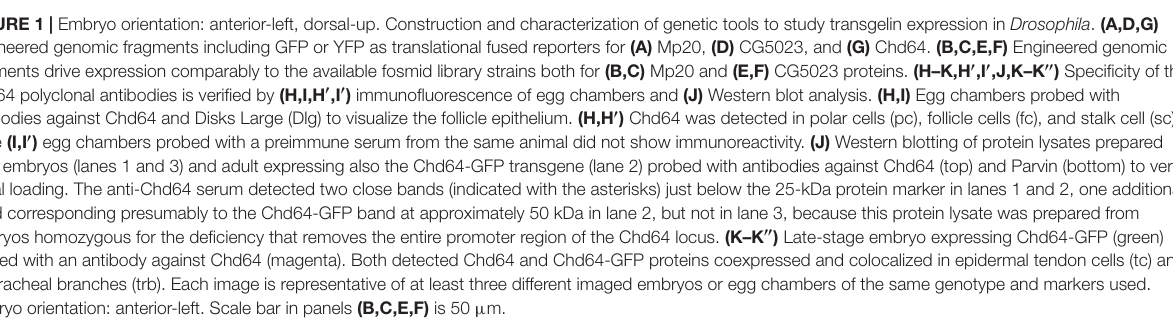
FIGURE 1 | Embryo orientation: anterior-left, dorsal-up. Construction and characterization of genetic tools to study transgelin expression in Drosophila . (A,D,G) Engineered genomic fragments including GFP or YFP as translational fused reporters for (A) Mp20, (D) CG5023, and (G) Chd64. (B,C,E,F) Engineered genomic fragments drive expression comparably to the available fosmid library strains both for (B,C) Mp20 and (E,F) CG5023 proteins. (H–K,H (cid:48) ,I (cid:48) ,J,K–K (cid:48)(cid:48) ) Specificity of the Chd64 polyclonal antibodies is verified by (H,I,H (cid:48) ,I (cid:48) ) immunofluorescence of egg chambers and (J) Western blot analysis. (H,I) Egg chambers probed with antibodies against Chd64 and Disks Large (Dlg) to visualize the follicle epithelium. (H,H (cid:48) ) Chd64 was detected in polar cells (pc), follicle cells (fc), and stalk cell (sc), while (I,I (cid:48) ) egg chambers probed with a preimmune serum from the same animal did not show immunoreactivity. (J) Western blotting of protein lysates prepared from embryos (lanes 1 and 3) and adult expressing also the Chd64-GFP transgene (lane 2) probed with antibodies against Chd64 (top) and Parvin (bottom) to verify equal loading. The anti-Chd64 serum detected two close bands (indicated with the asterisks) just below the 25-kDa protein marker in lanes 1 and 2, one additional band corresponding presumably to the Chd64-GFP band at approximately 50 kDa in lane 2, but not in lane 3, because this protein lysate was prepared from embryos homozygous for the deficiency that removes the entire promoter region of the Chd64 locus. (K–K (cid:48)(cid:48) ) Late-stage embryo expressing Chd64-GFP (green) probed with an antibody against Chd64 (magenta). Both detected Chd64 and Chd64-GFP proteins coexpressed and colocalized in epidermal tendon cells (tc) and the tracheal branches (trb). Each image is representative of at least three different imaged embryos or egg chambers of the same genotype and markers used. Embryo orientation: anterior-left. Scale bar in panels (B,C,E,F) is 50 µ